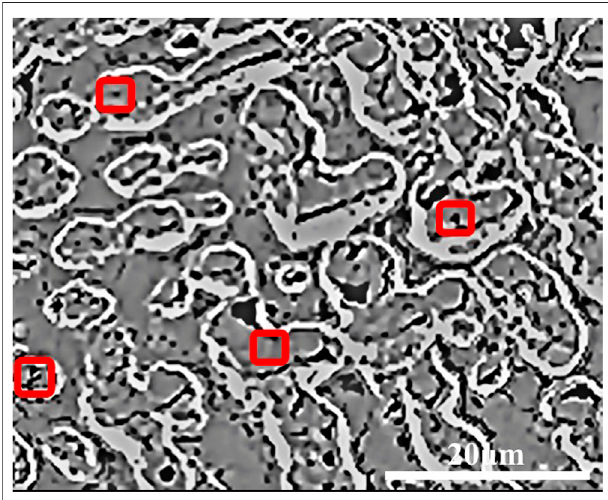
Frontiers in Materials |